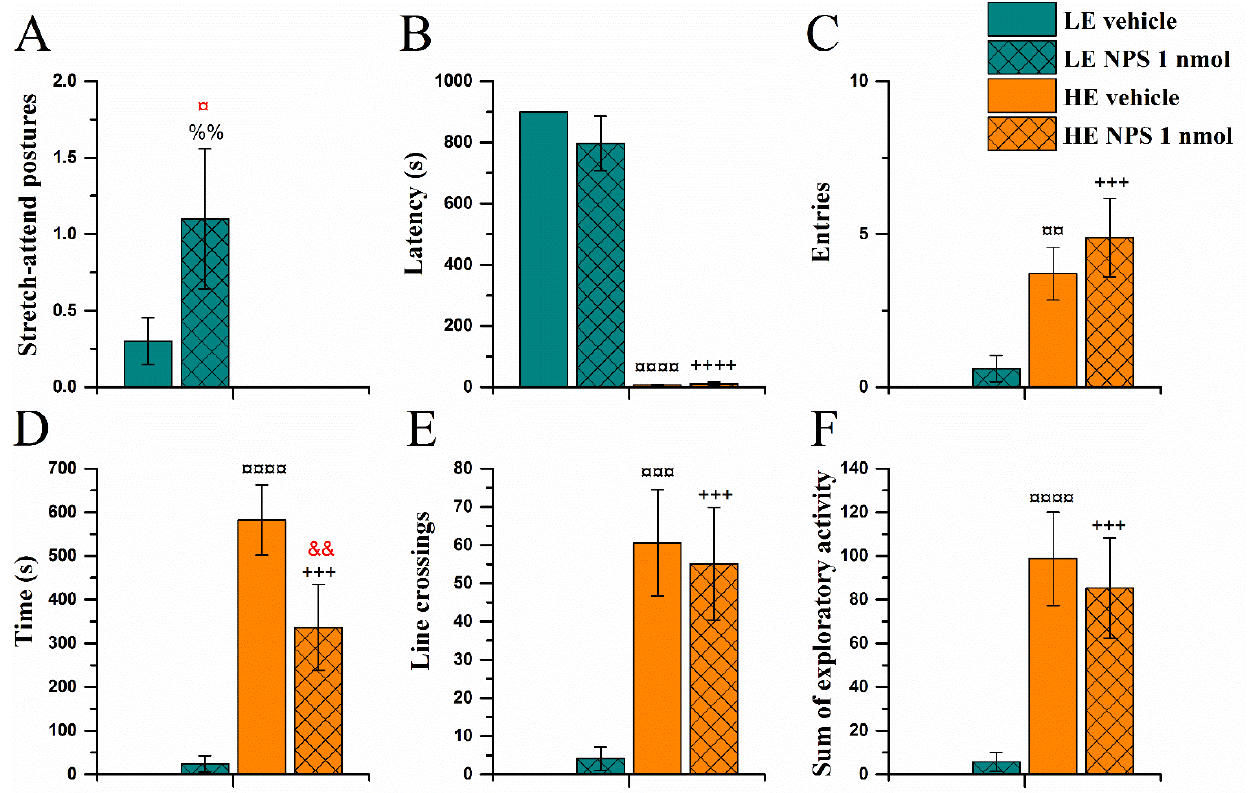
Figure 6. Behaviour in the exploration box test (EBT) approximately 40 min after vehicle/NPS (1 nmol, i.c.v.) administration: strech-attend postures ( A ), latency to enter ( B ), entries into ( C ), time spent, ( D ), line crossings ( E ), and sum of exploratory activity ( F ) in the open part of the EBT apparatus (data shown as mean ± SEM). &&: p < 0.01 vs. HE vehicle; ¤, ¤¤, ¤¤¤, ¤¤¤¤: p < 0.05, 0.01, 0.001, 0.0001 vs. LE vehicle, respectively; %%: p < 0.01 vs. HE NPS; +++, ++++: p < 0.001, 0.0001 vs. LE NPS, respectively. Red colour denotes difference from respective vehicle group. HE: high exploring rats; LE: low exploring rats; NPS: neuropeptide S. HE vehicle ( n = 7); HE NPS ( n = 9); LE vehicle ( n = 10); LE NPS ( n = 10).